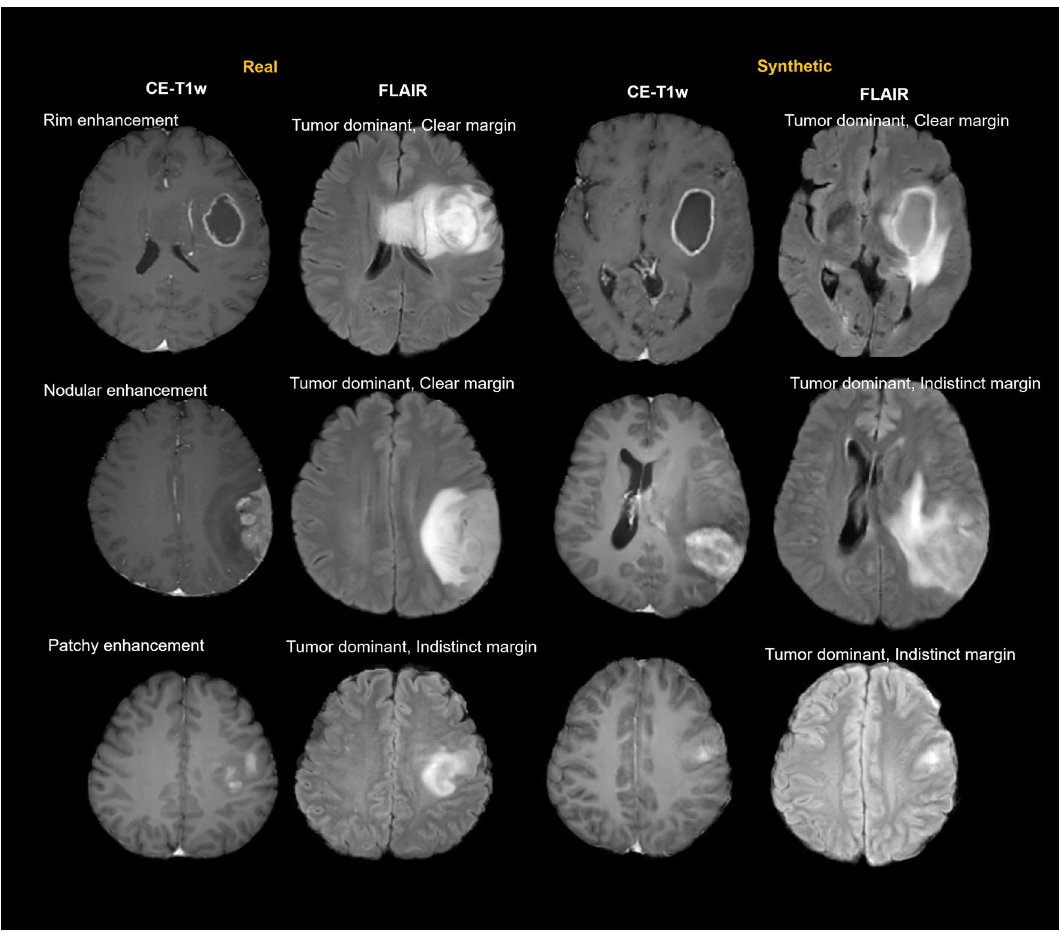
Figure 2. Morphologic characteristics of real IDH-mutant glioblastomas (left) and synthetic IDH-mutant glioblastomas generated by a generative adversarial network (right) based on contrast-enhanced T1-weighted (CE-T1w) and paired FLAIR images. ( A ) CE-T1w images showing different contrast patterns of rim enhancement, thick nodular enhancement, and patch enhancement. ( B ) FLAIR images showing types of surrounding high signal intensity (tumor dominant and edema dominant) and margins of non-enhancing lesions (clear and indistinct). Although the appearances of synthetic images are similar to those of real images, there were no exact